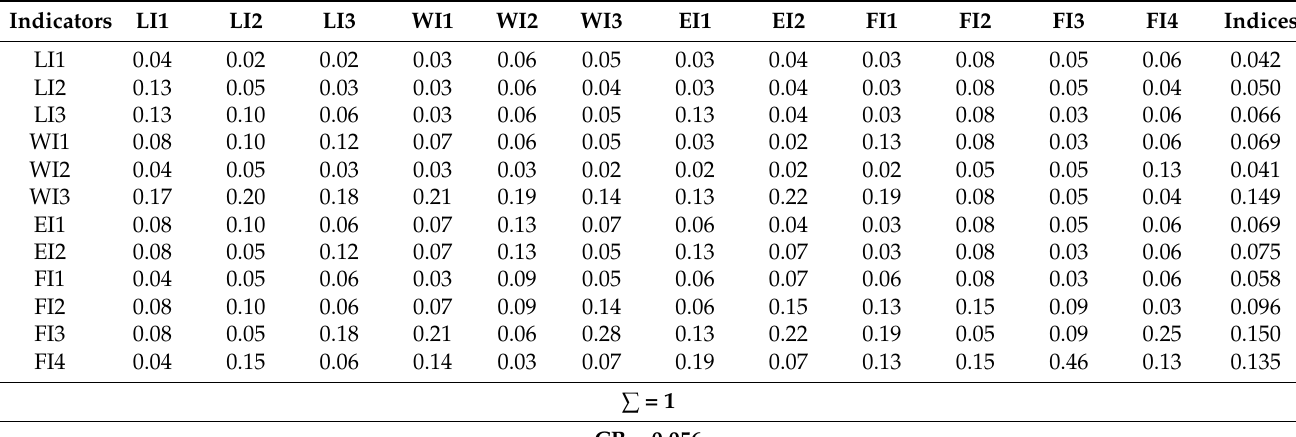
Table 4. Normalized pairwise comparison, Consistence ratio and composite index for LWEF nexus resources in the study